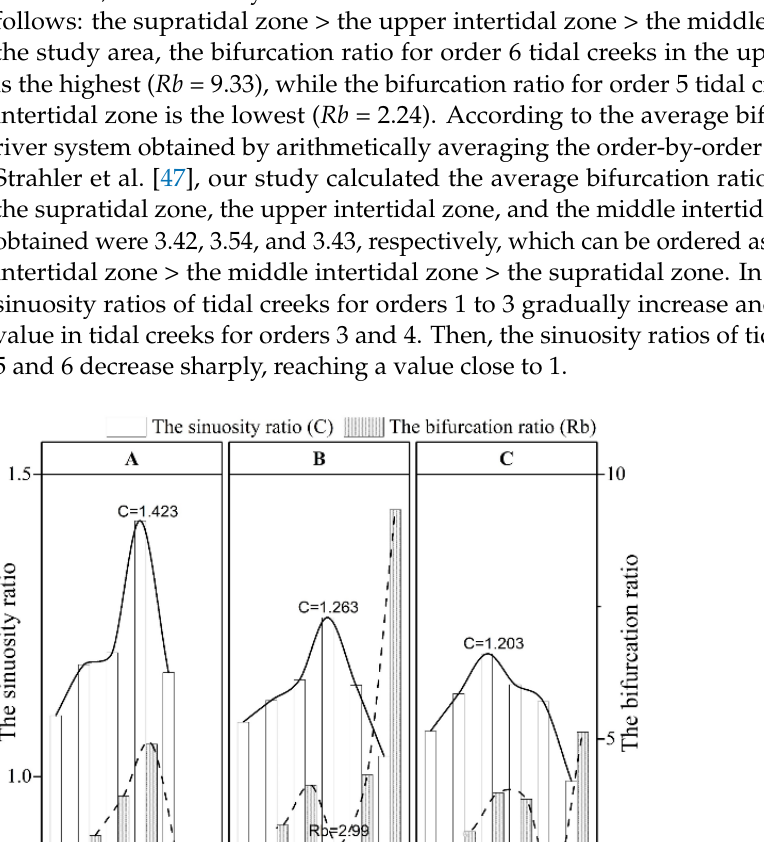
Figure 10. Statistics of sinuosity ratios and bifurcation ratios of tidal creeks of different orders in the coastal wetlands of the Liao River Estuary. (A: the supratidal zone; B: the upper intertidal zone; C: the middle intertidal zone.).